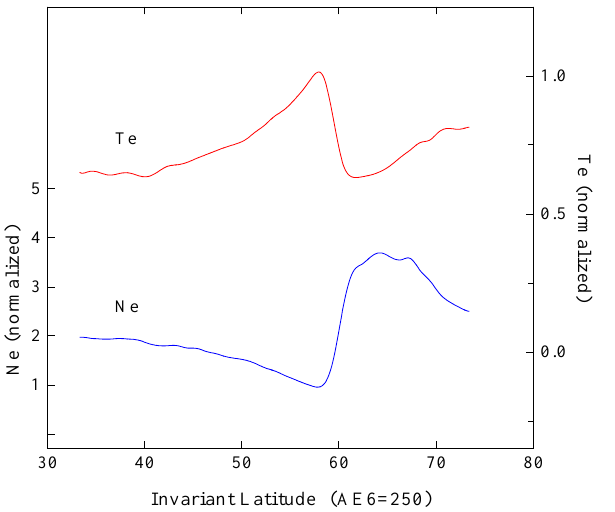
Fig. 11. Mean latitudinal profiles of the electron density (blue curve) and electron temperature (red curve) at the location of the polar cliff. The format of data presentation corresponds to that in Fig. 10, ex- cept that this time only the median curves are shown. In both cases, the foot of the polar cliff latf serves as a common reference location. In addition, all density and temperature values have been normal- ized to the respective density and temperature values Ne(latf) and Te(latf) observed at this location.